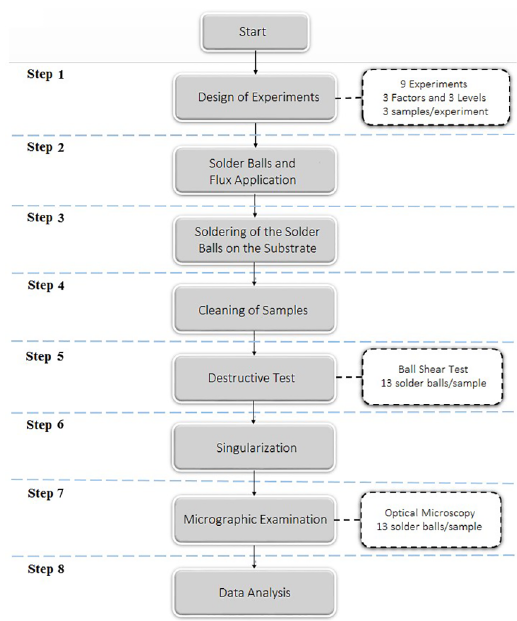
Figure 1. Flowchart showing the experiment stages.